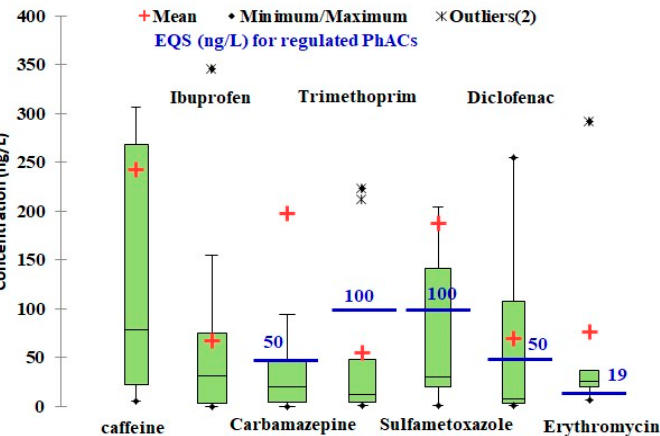
Figure 2. Variation of common pharmaceuticals in surface waters of Lower Danube basin compared to the proposed EQS, according to the Decisions 2018/840/EU and 2020/1161/EU. Concentrations exceeding—EQS of carbamazepine, sulfamethoxazole, trimethoprim, diclofenac, and erythromycin were found in the Danube tributaries such as Morava river [38], Arge ş river [10,44,49], Mure ş river [51], and Jijia river [53], in sites that are heavily im- pacted by municipal or industrial wastewater discharges. Thus, the highest concentrations of carbamazepine (945 ng/L), sulfamethoxazole (204 ng/L) and diclofenac (255 ng/L) were reported in the Arges River, highly affected by the municipal and industrial discharges of the capital of Romania, the city of Bucharest. The concentration measured in the Danube River for the pharmaceuticals mentioned in the “Watch lists” [36,37] were below EQS. trations of carbamazepine of 559 ng/L were reported in River Fyrisån (Sweden), 490 ng/L in river Grundlach (Germany), and 1670 ng/L in Ebro basin (Spain) [54]. High concentra- tion of diclofenac of 930 ng/L was previously reported in upper Danube (Budapest, Hun- gary, September 2008) [55]. Sulfamethoxazole concentrations of 540 ng/L in surface water were recently reported in the upper Danube catchment area in Croatia [56].